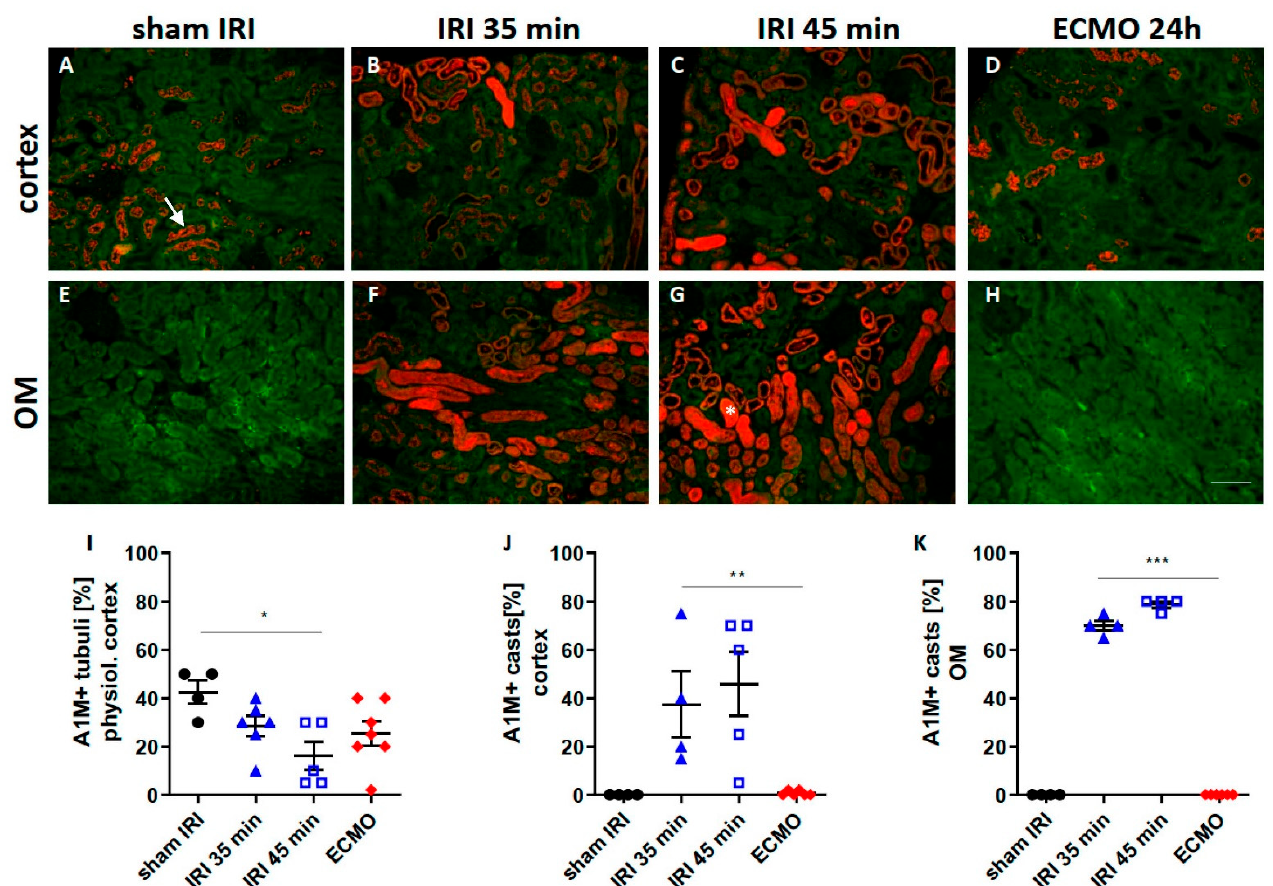
Figure 3. Staining for the tubular transport marker A1M in the kidney after moderate and severe renal IRI compared with ECMO. The renal cortex (upper row) and outer medulla (lower row) of A1M-stained kidney sections are shown 24 h after moderate ( B , F ) and severe ( C , G ) renal IRI and 24 h ( D , H )) after ECMO. The A1M staining signal is shown in red, tubular autofluorescence in green. Sham-IRI mice and sham-ECMO mice had similar A1M staining and sham-IRI control is shown for convenience ( A , E ). Physiologically, a tubular granular staining pattern of A1M can be observed (( A ), white arrow). In conditions of tubular transport impairment, the granular tubular staining pattern is reduced and A1M accumulates in the tubular lumen forming casts (( G ), white asterisk). Moderate and severe IRI were associated with a reduction in the physiologic A1M signal ( I ) and an increase in A1M cast formation ( B , C , F , G , J , K ) indicating impairment tubular transport function. ECMO did not cause A1M cast formation ( D , H , J , K ) indicating preserved tubular transport function. N = 4–7 mice each group are shown. * p < 0.05, ** p < 0.01, *** p < 0.001. Scale bar 100 µm.